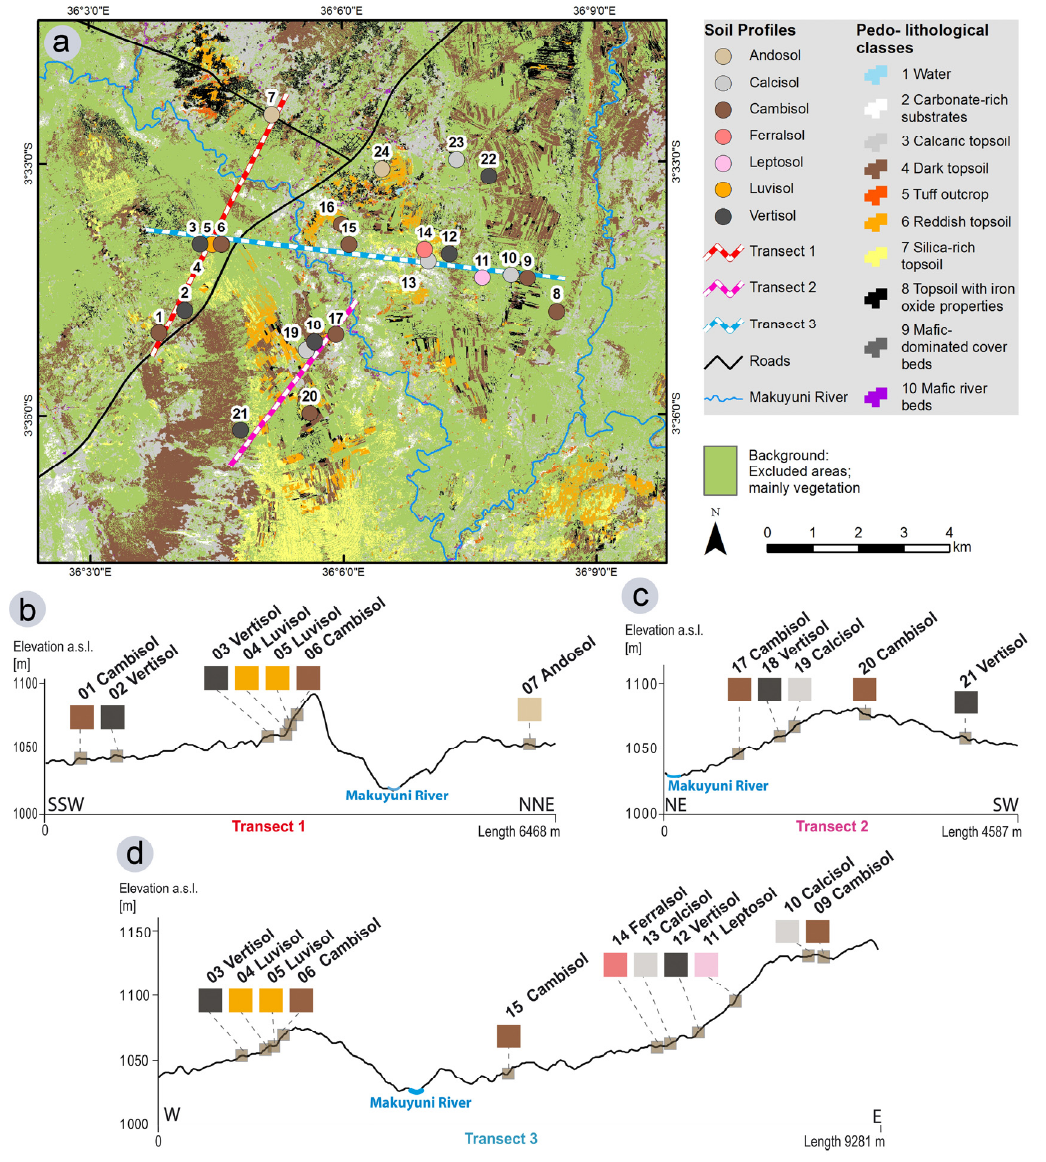
Figure 7. Section of the classification with soil profile transects. ( a ) Map with soil profile transects; ( b ) Soil profile transect 1 (SSW – NNE orientation); ( c ) Soil profile transect 2 (NE–SW orientation); ( d ) Soil profile transect 3 (W–E